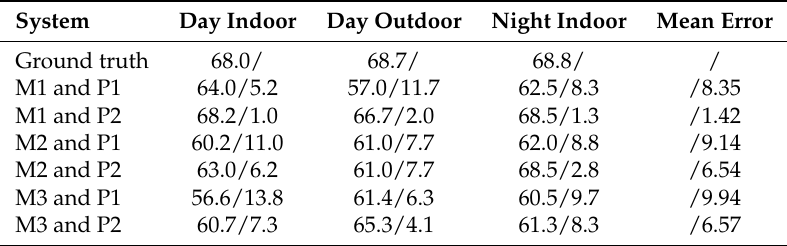
Table 1. Mean and errors of heart rates in beats per minute (BPM) estimated by different methods when the subject was at rest. “M1 and P2” represents the results of the proposed system. The values to the right of the/represent errors.